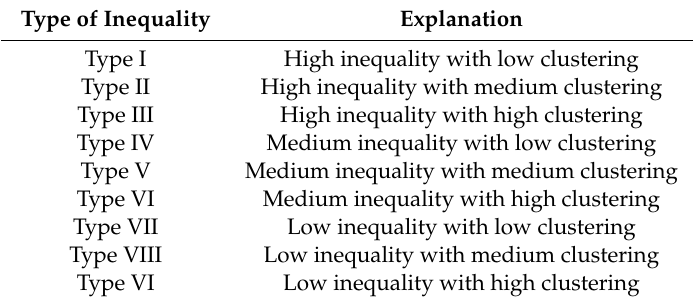
Table 2. Explanation of city types.